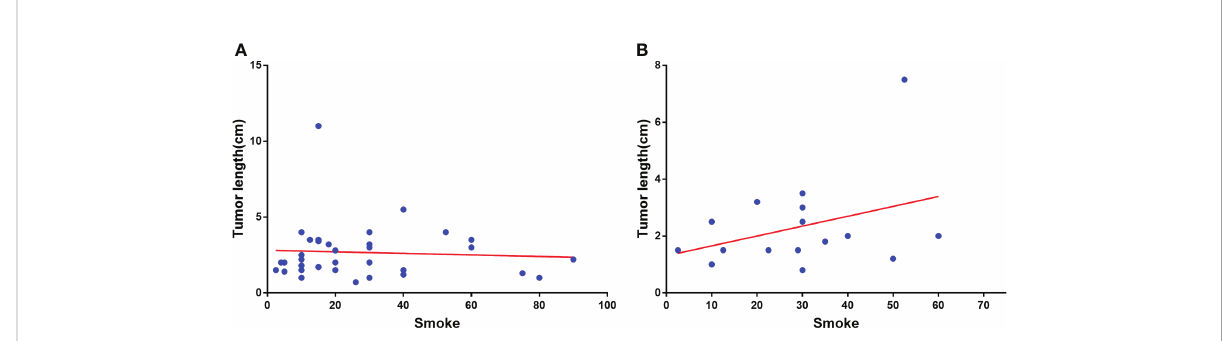
FIGURE 1 Correlation analysis of smoking amount with the largest lesion diameter of SP- (A) and MP-LUAD (B)